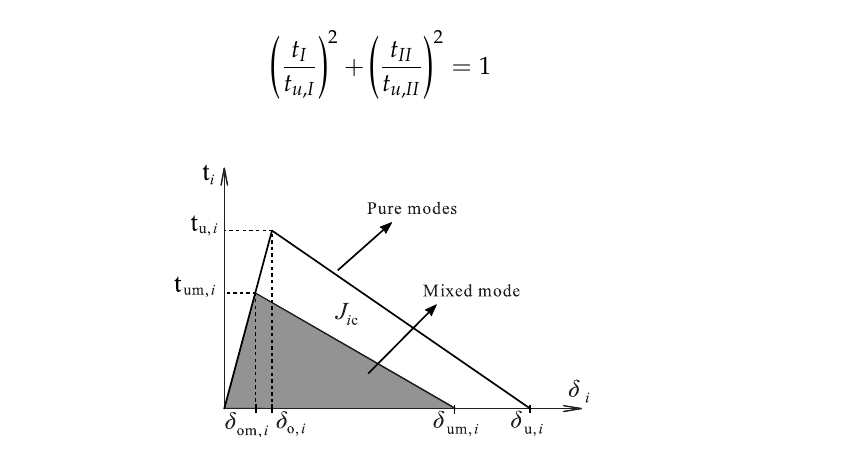
Figure 7. Bilinear cohesive zone model for pure modes (I and II) and mixed-mode (I + II).